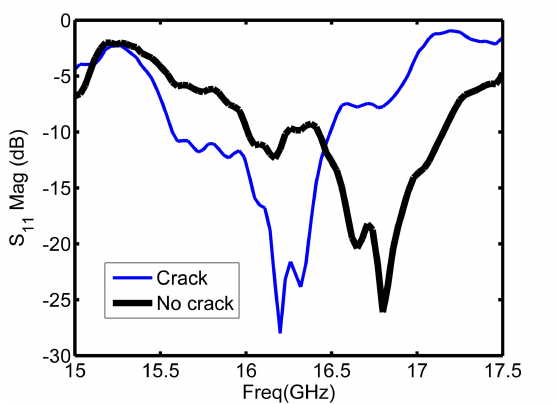
Figure 5. Reflection coefficient magnitude plot around the resonance frequency of the